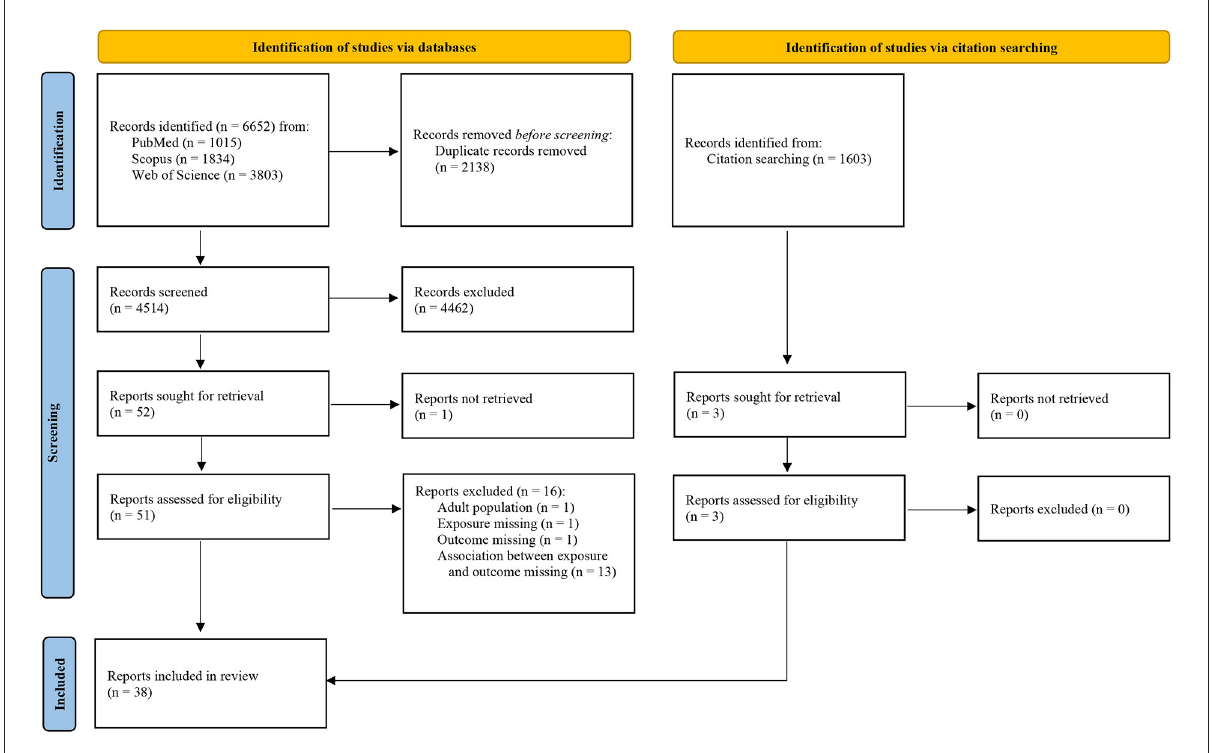
FIGURE1 Study selection flow chart according to PRISMA 2020 guidelines (17).